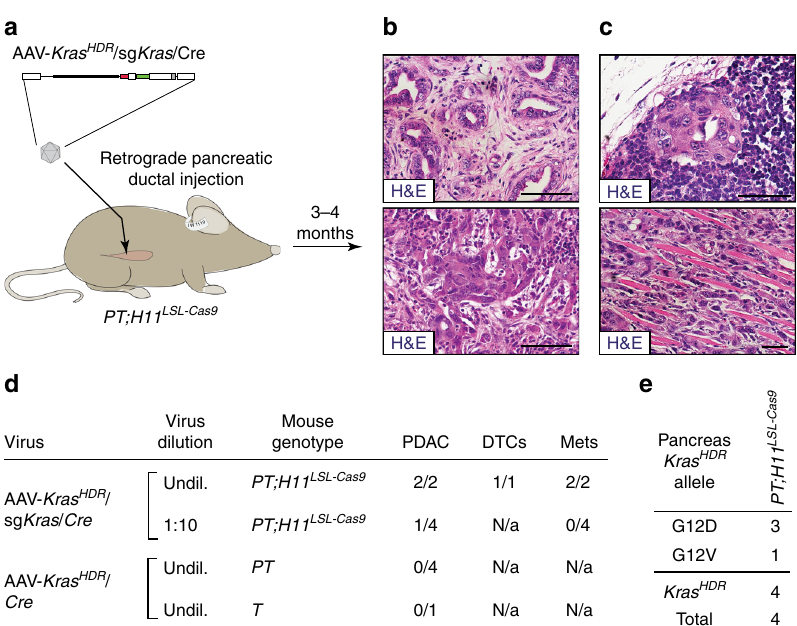
Fig. 4 Introduction of mutant Kras variants into pancreatic cells using AAV/Cas9-mediated HDR drives the formation of metastatic PDAC. a Schematic of retrograde pancreatic ductal injection of AAV- Kras HDR /sg Kras / Cre ( ∼ 1.7 × 10 11 vector genomes per mouse) into PT;H11 LSL-Cas9 mice to induce pancreatic cancer. b Histology of pancreatic tumors initiated by retrograde pancreatic ductal injection of AAV- Kras HDR /sg Kras / Cre into PT;H11 LSL-Cas9 mice. Scale bars = 75 µ m. c Histology of metastases in the lymph node (upper panel) and diaphragm (lower panel) in PT;H11 LSL-Cas9 mice with PDAC. Scale bars = 50 µ m. d Incidence of PDAC, DTCs in the peritoneal cavity, and metastases in the indicated genotypes of mice (shown as the number of mice with cancer, DTCs, or metastases out of the total number of mice analyzed), 3 – 13 months after transduction with either AAV- Kras HDR /sg Kras / Cre or AAV- Kras HDR / Cre ( ∼ 2.9 × 10 11 vector genomes per mouse). AAV- Kras HDR /sg Kras / Cre was administered at the stock concentration ( “ undil. ” ) or at a 1:10 dilution ( “ 1:10 ” ). e HDR-generated oncogenic Kras alleles in individually dissected pancreatic tumor masses. Number of tumors with each allele is indicated. Alleles that were not identi fi ed in any pancreatic tumor masses are not